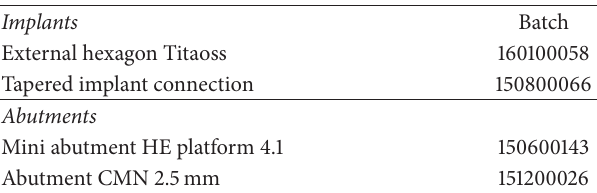
Table 1: Implants and abutments